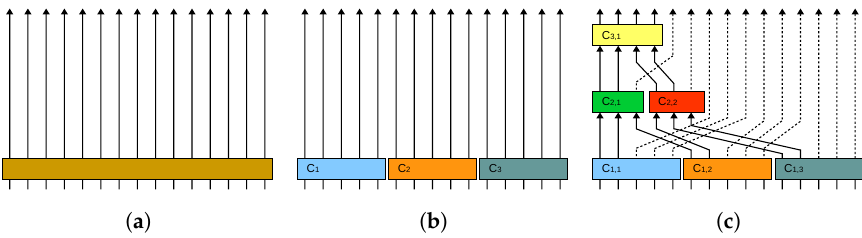
Figure 8. Structure of plain KLT/RKLT, Classical Clustering KLT/RKLT, and Multilevel Clustering KLT/RKLT. This example decorrelates 15 spectral channels. Each arrow denotes a channel and each coloured rectangle represents the computation of a KLT/RKLT transform. In the case of Classical Clustering KLT/RKLT, three clusters are employed. In the case of Multilevel Clustering KLT/RKLT, 3 levels of Multilevel Clustering are applied. ( a ) Plain KLT/RKLT; ( b ) Classical Clustering KLT/RKLT; ( c ) Multilevel Clustering KLT/RKLT.